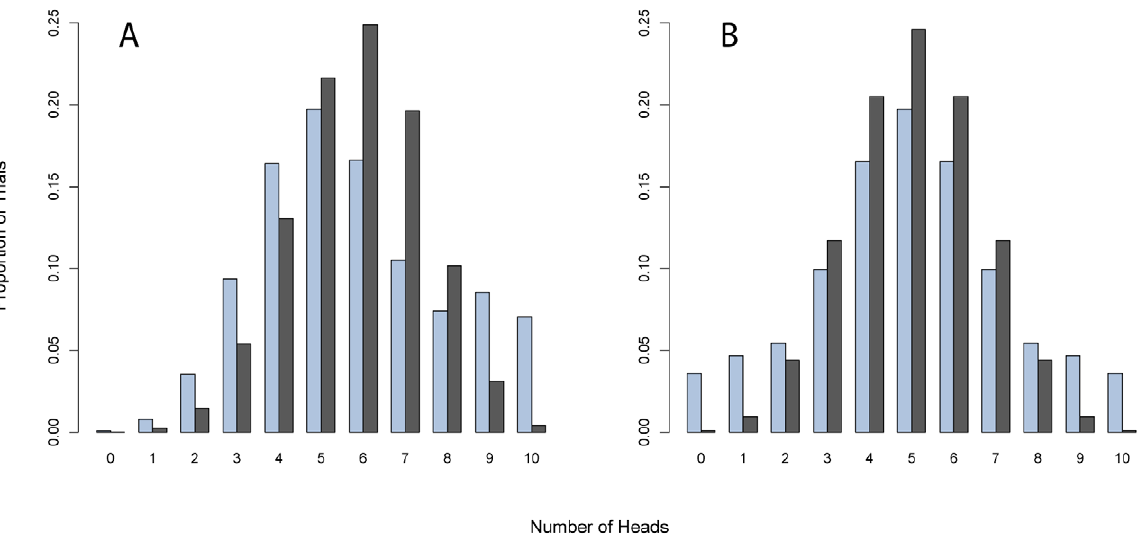
Figure 1. Mixtures of biased coins in a set of largely neutral coins generate substantially increased variances compared to uniform coins with the same bias. (A) shows distribution of the outcome of coin tosses generated using an 80:20 mixture of neutral coins and biased coins (probability of a head =.9), compared with the outcome of a series of biased coin tosses (probability of a head =.58); the mixed coin toss (blue) has the same mean bias (p=.58) as the biased coin toss (black). (B) shows distribution of a 10:80:10 mixture of a biased coin (probability of a head =.1), neutral coin, and a biased coin (probability of a head =.9), compared with the outcome of a series of neutral coin tosses. In both simulations, coins are selected and flipped 10 times and the resulting number of heads, ranging from 0 through 10, are shown. The increased variance of the outcomes in the mixture setting carries information about the presence of some non-neutral coins in the experiment.